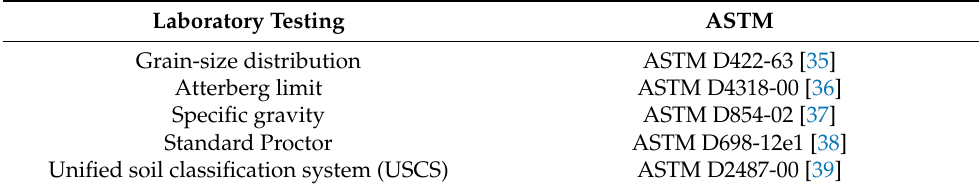
Table 1. ASTM standard for laboratory